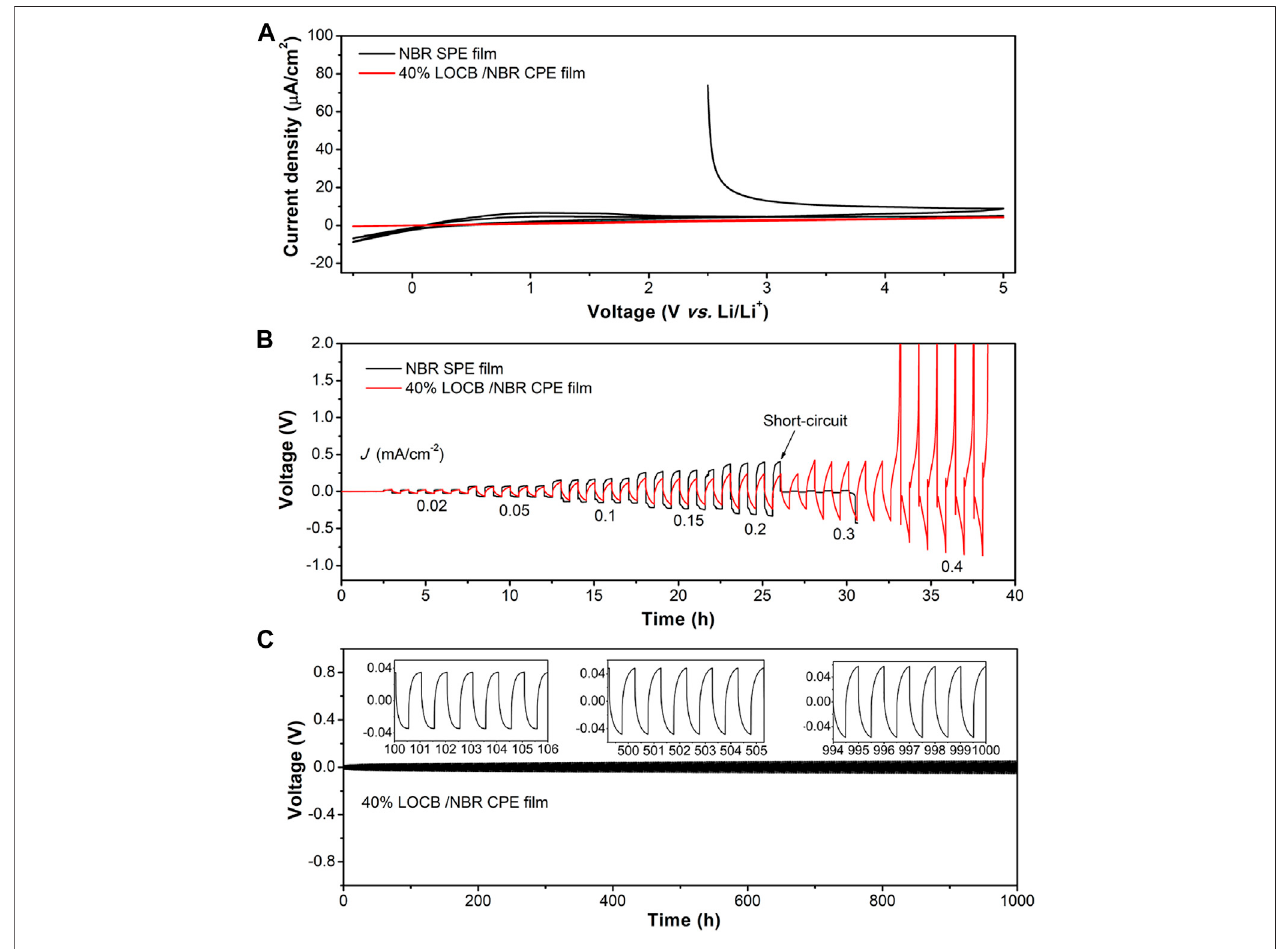
FIGURE 4 | Electrochemical properties of NBR SPE fi lm and LOCB/NBR CPE fi lm. (A) Cyclic voltammetry curves and (B) galvanostatic cycling of Li-Li cells at different current densities. (C) Galvanostatic cycling of Li-Li cell at 0.04 mA cm − 2 . The insets in C present the detailed polar voltage at speci fi c cycles.